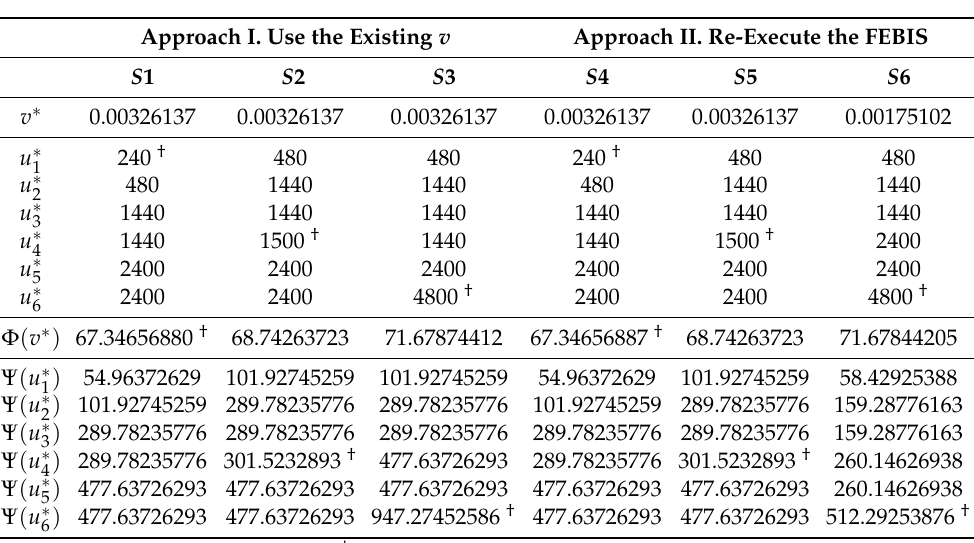
Table 4. Results of adding a new ICEB B † to the egg banking alliance A . Approach I. Use the Existing v